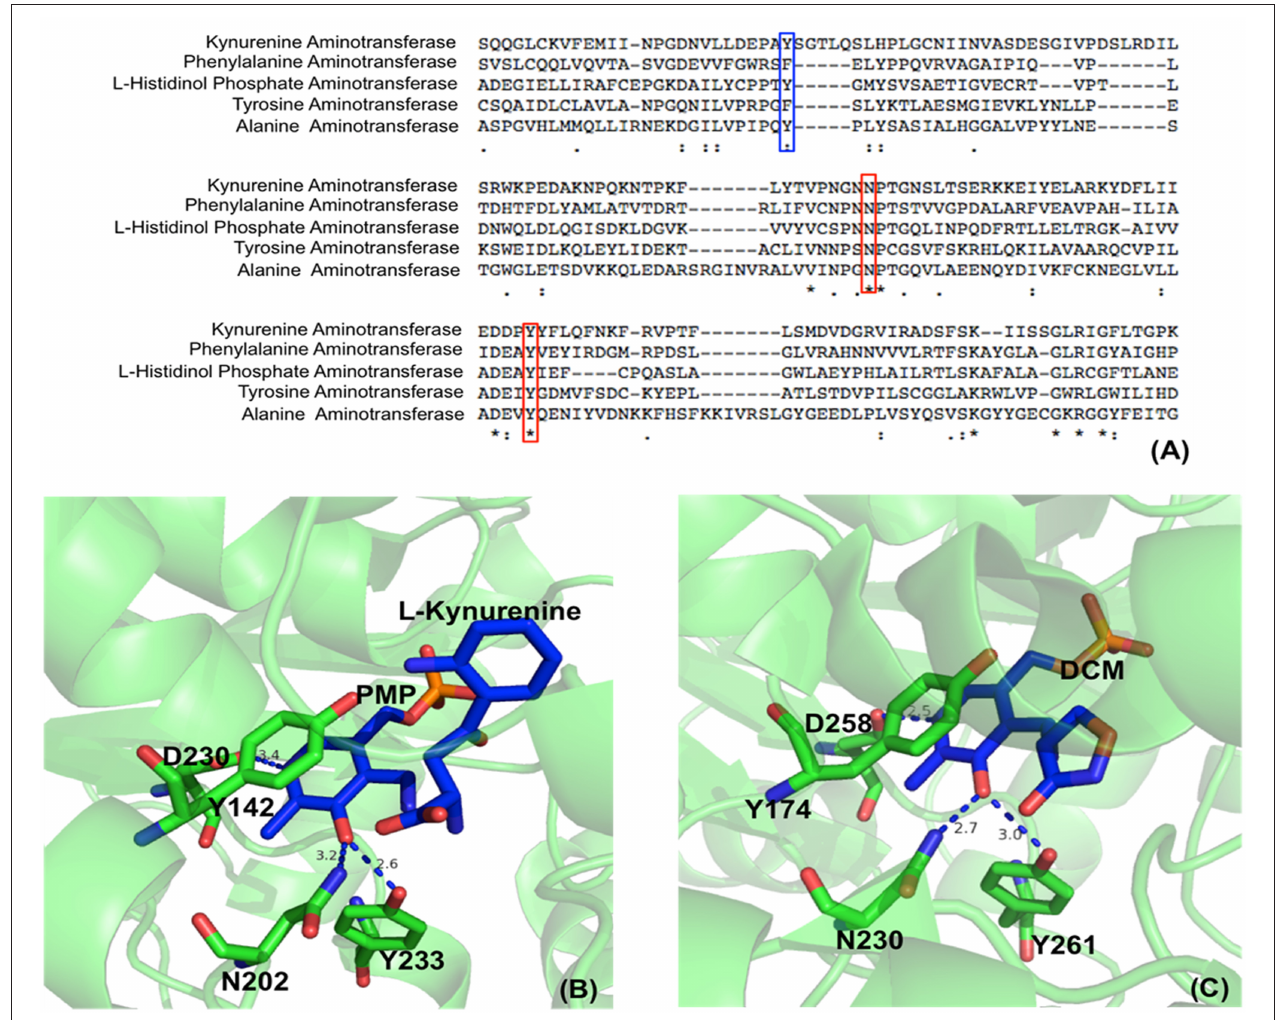
FIGURE 2 | Partial protein sequence alignment of aminotransferases, and the position of three conserved residues in the active site. Sequences of Homo sapiens kynurenine aminotransferase (Accession: NP_057312.1), Mycobacterium tuberculosis H37Rv phenylalanine aminotransferase (PDB: 4R2N, chain A) (Nasir et al., 2016 ), Enterobacteriaceae L-histidinol phosphate aminotransferase (Accession: WP_000108941.1), Homo sapiens tyrosine aminotransferase (PDB: 3DYD, chain A) (http://www.rcsb.org/structure/3DYD) and Hordeum vulgare alanine aminotransferase (PDB: 3TCM, chain A) ( Duff et al., 2012) are shown. The uncharged aromatic amino acid residues for π - π stacking with PLP ring are highlighted in blue box while the Asn and Tyr residues forming hydrogen bonds with PLP O3 ′ are highlighted in red boxes (A) . The Asn and Tyr residues forming hydrogen bonds with O3 ′ of PLP are shown in green sticks while the ligands pyridoxamine phosphate (PMP), L-kynurenine and D-pyridoxyl-N,O-cycloserylamide-5-monophosphate (DCM) are shown in blue sticks. The uncharged aromatic amino acid residues forming π - π stacking with PLP pyridine ring and the Asp residue near pyridine ring N atom are also shown in green sticks. The distances between PLP O3 ′ and Asn or Tyr and the distances between pyridine ring N and Asp side chain are in blue dashed line and labeled (Unit: Å). L-kynurenine aminotransferase (PDB: 2R2N) (Han et al., 2008b) (B) and alanine aminotransferase (PDB: 3TCM) (Duff et al., 2012) (C) are presented as two